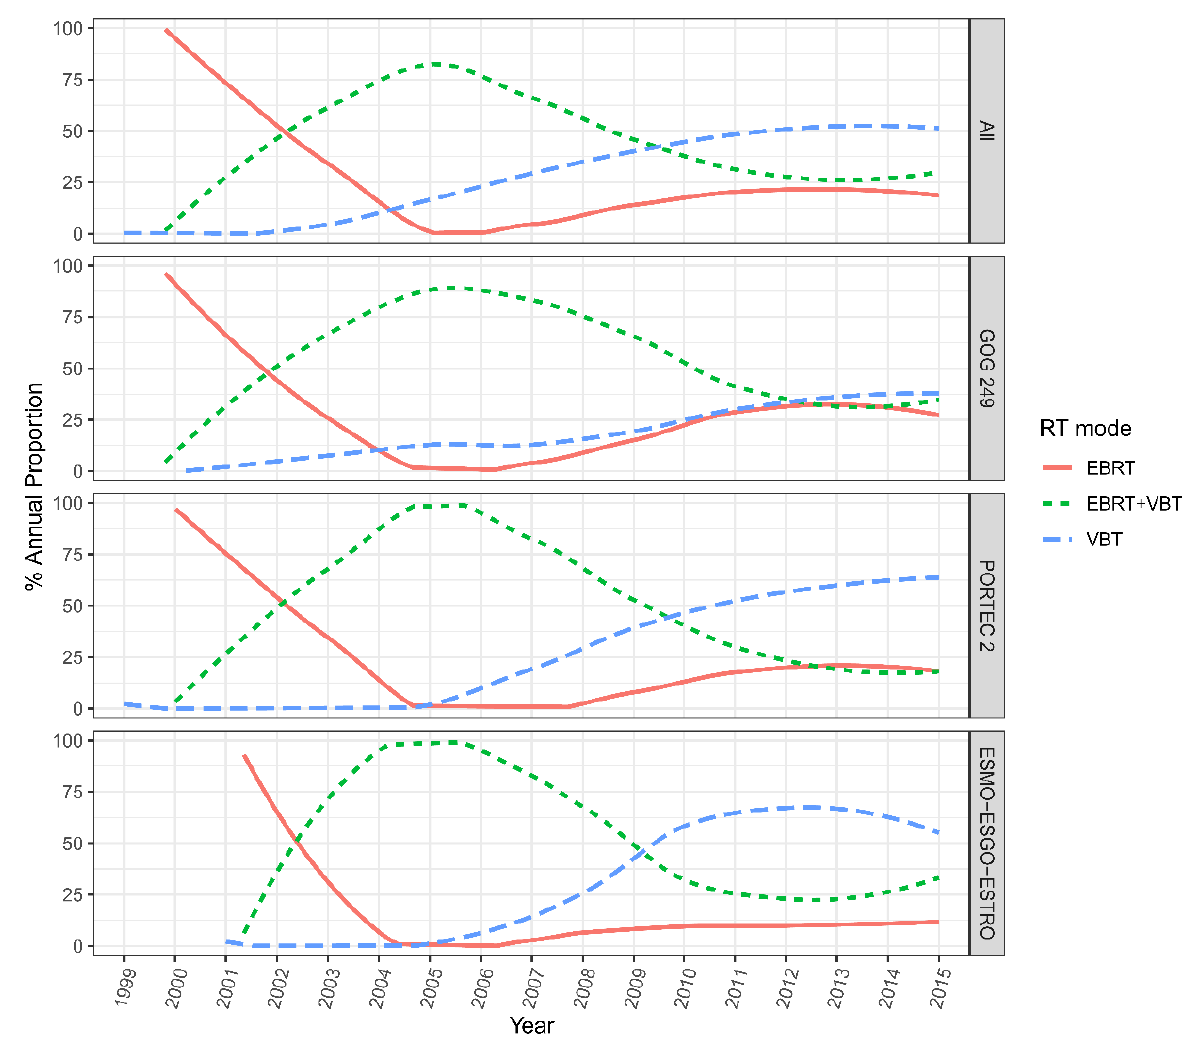
Figure 2. Evolving trends in RT mode utilization in patients meeting HIR criteria across the 13 medical centers in China. EBRT = external beam radiation therapy; VBT = vaginal brachytherapy.